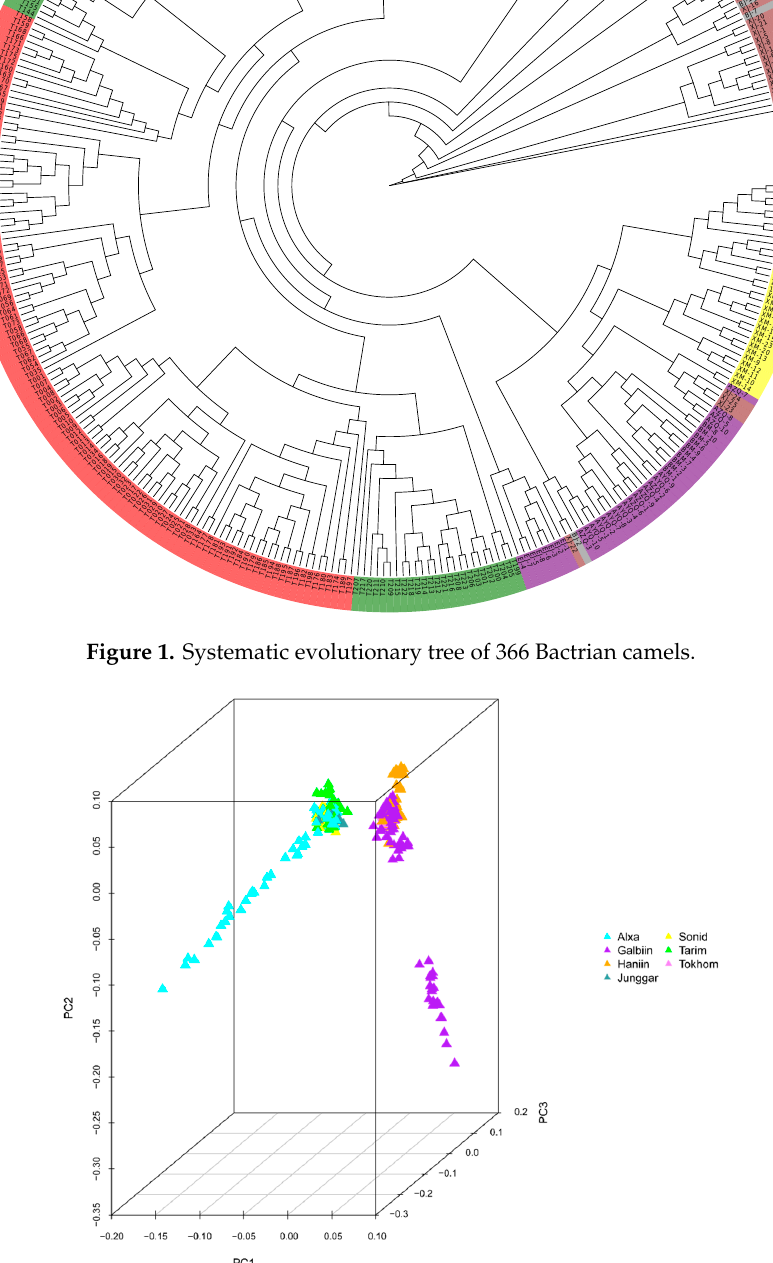
Figure 2. Principal component analysis (PCA) of 366 Bactrian camels. The sample population comprised four Chinese domestic breeds—the Alxa Bactrian camel (Alxa), the Junggar Bactrian camel (Junggar), the Sunite Bactrian camel (Sonid), and the Tarim Bactrian camel (Tarim)—and three Mongolian domestic breeds—the Galbiin Gobiin Ulaan Bactrian camel (Galbiin), the Haniin Hetsiin Huren Bactrian camel (Haniin), and the Tokhom Tongalag Bactrian camel (Tokhom).